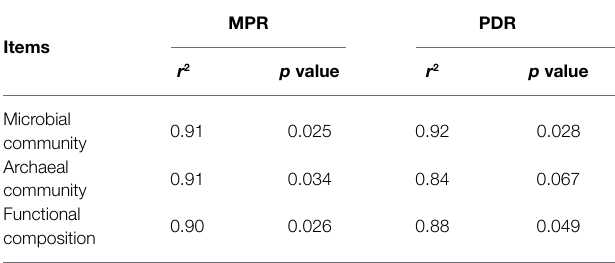
TABLE 1 | Mantel correlations among microbial community, archaeal community, functioanl composition, methane production rate (MPR), and phenanthrene degradation rate (PDR) in the enriched